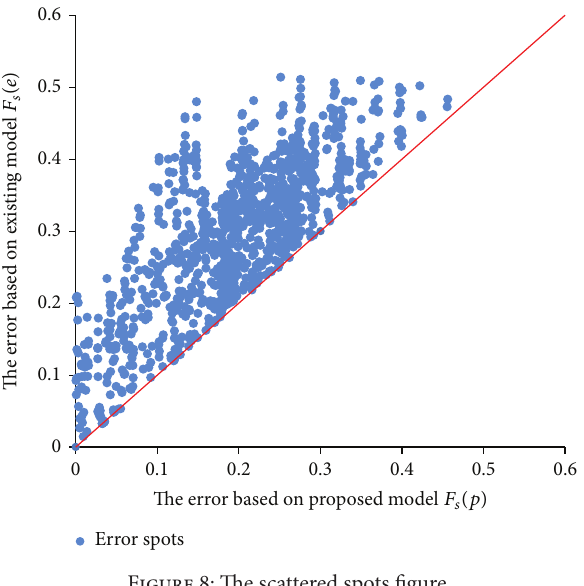
Figure 8: The scattered spots